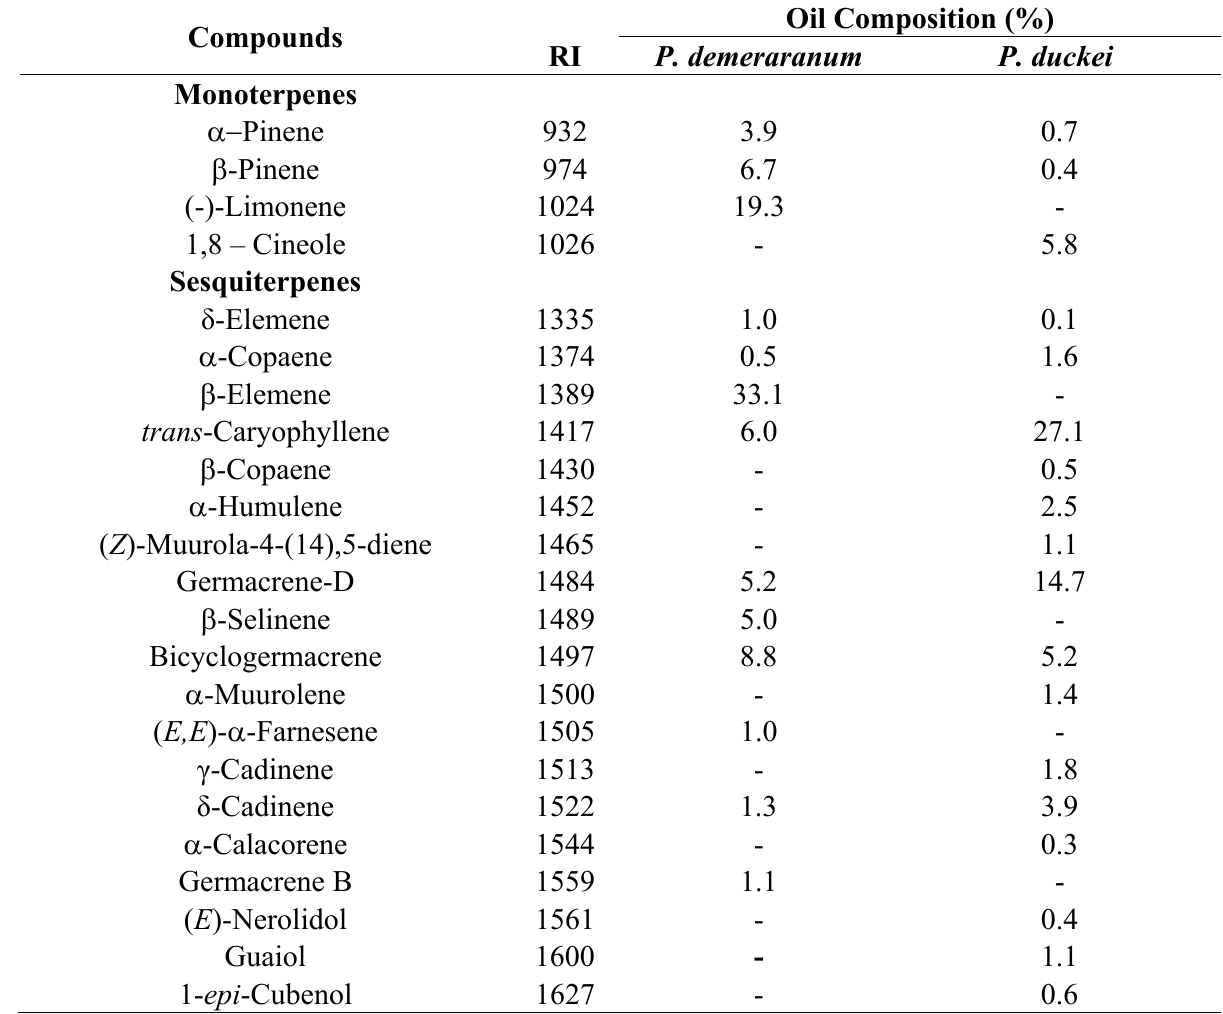
Table 1. Chemical composition of the leaf essential oils of P. demeraranum and P. duckei